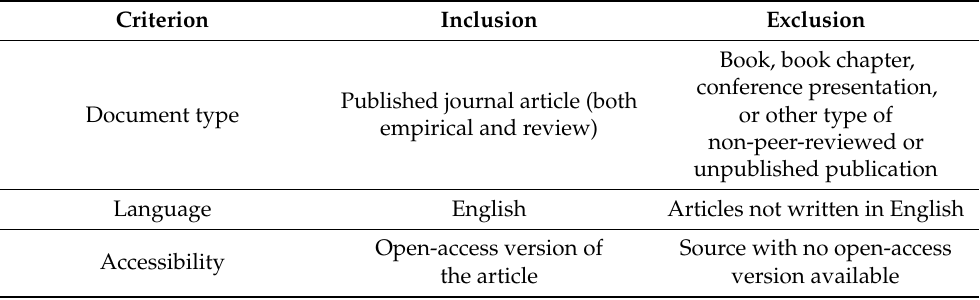
Table 1. The criteria for eligibility.